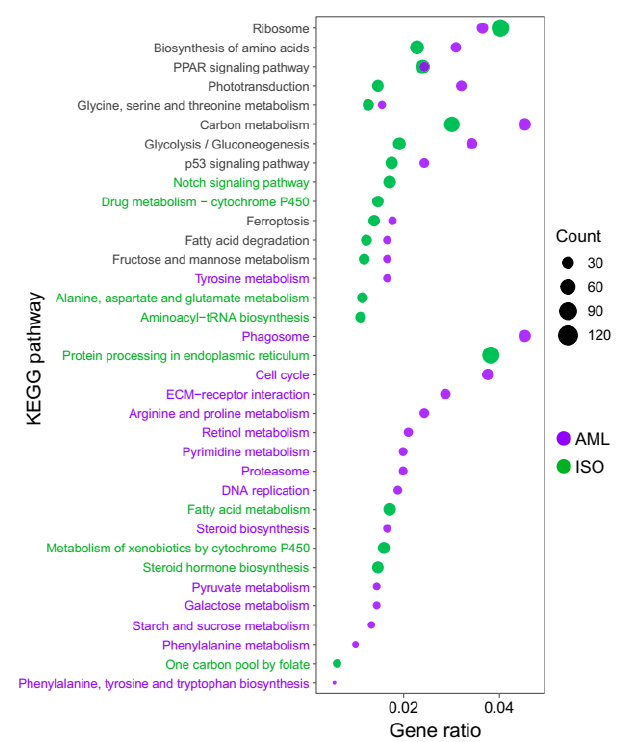
Figure 5. KEGG enrichment analysis of the differentially expressed genes in AML- and ISO-exposure